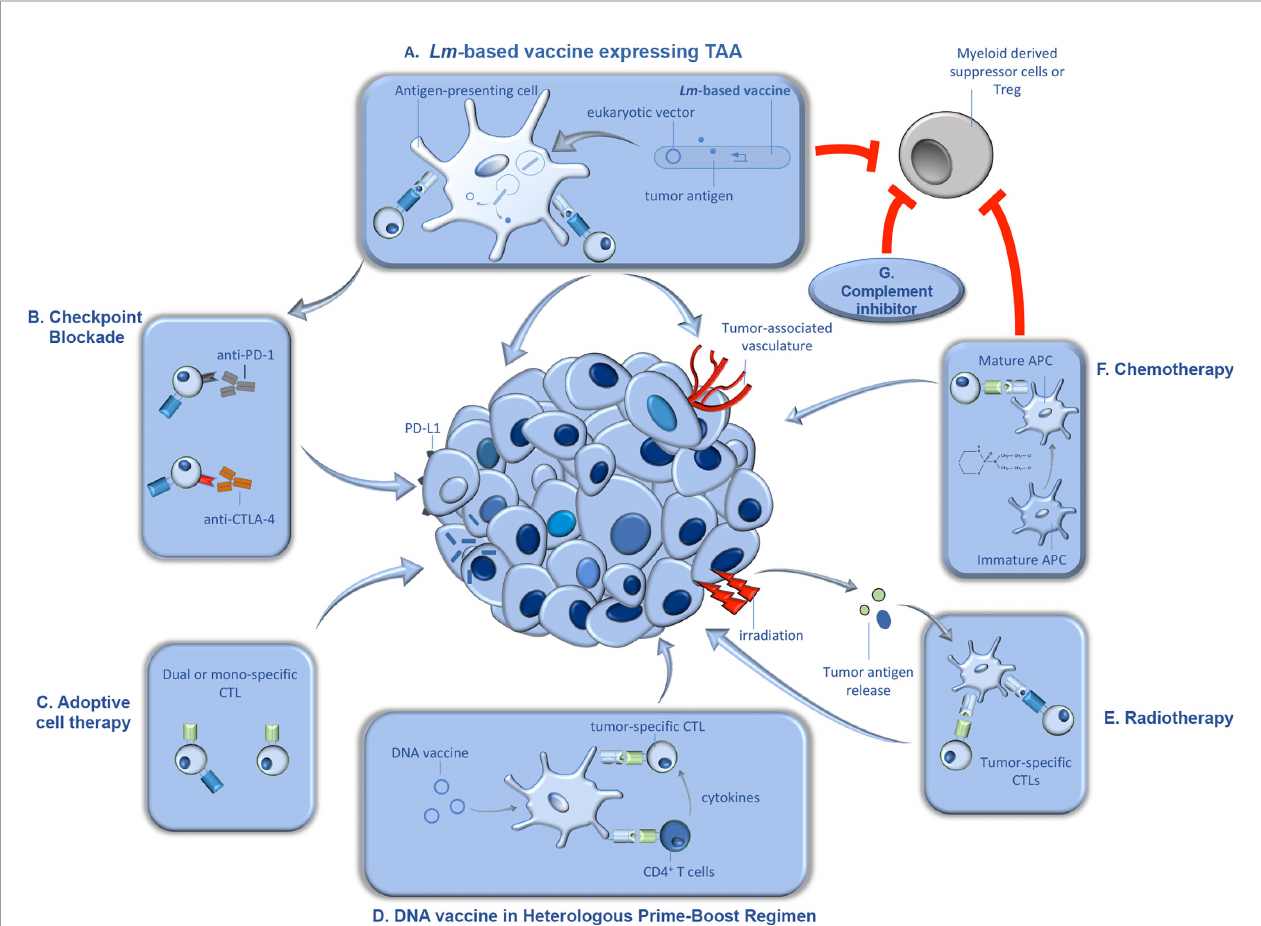
FIGURE 1 | Synergistic therapeutic approaches with Lm -based vaccines in tumor immunotherapy. Lm -based vaccines have found therapeutic success in preclinical models of cancer for decades, and recent studies demonstrated signi fi cant promise for this type of active tumor immunotherapy in clinical trials. Further, recent studies suggest that the anti-tumor ef fi cacy of Lm -based vaccines can be signi fi cantly improved when utilized in combination with synergistic anti-cancer therapeutics. In this fi gure, we detail some of the anti-cancer therapeutics that demonstrated ef fi cacy in combination Lm -based vaccines along with their proposed mechanism(s) of action. (A) Upon administration, attenuated Lm vaccines infect antigen presenting cells in secondary lymphoid organs and gain entry to the cytosol, wherein they produce and secrete tumor antigen and/or release eukaryotic expression vectors encoding for tumor antigen. Once delivered by Lm , the tumor antigens go through processing and presentation to naïve tumor-speci fi c CD4 + and CD8 + cytotoxic T lymphocytes (CTLs). Tumor-speci fi c CTLs, activated through the action of Lm -based vaccines, migrate to the tumor microenvironment (TME) and lyse tumor cells and/or cells associated with the tumor vasculature. Importantly, Lm -based vaccines can also reduce immunosuppression within the TME by reducing tumor-associated MDSCs and Tregs. (B) Upon continuous activation, tumor- speci fi c CTLs can become exhausted, characterized by the upregulation of inhibitory molecules such as programmed cell death protein 1 (PD-1) and cytotoxic T-lymphocyte-associated protein 4 (CTLA-4). Antibody-mediated blockade of inhibitory molecules results in enhanced T cell function and synergy with Lm -based vaccine anti-tumor responses. (C) Dual or mono-speci fi c adoptively transferred CTLs targeting both tumor antigens and/or Lm -derived antigens work in concert with Lm- based vaccines, delivered intratumorally, through increasing the breadth of the anti-tumor T cell response. (D) Lm -based vaccines have also been found to be effective in heterologous prime-boost approaches. DNA-based tumor vaccines, used as either prime or boost in a heterologous prime-boost vaccination schedule with Lm -based vaccines, induce robust expansion of Th1 helper T cells that produce cytokines in support of responses by tumor-speci fi c CTLs. (E) Further, radiation can synergize with Lm -based vaccines, in part, by causing direct tumor death, resulting in release of tumor antigens which are processed and presented by APCs to tumor-speci fi c T cells. (F) Chemotherapeutic agents such as cyclophosphamide can also synergize with Lm -based vaccines, in part, by facilitating maturation of APCs. However, cyclophosphamide can also reduce immunosuppressive cell types, Tregs and MDSCs, in the TME allowing for improved anti-tumor ef fi cacy by the anti-tumor responses induced by Lm -based vaccines. (G) Similarly, inhibition of complement signaling can synergize with Lm -based vaccines, in part, through limiting recruitment of MDSCs and Tregs to the